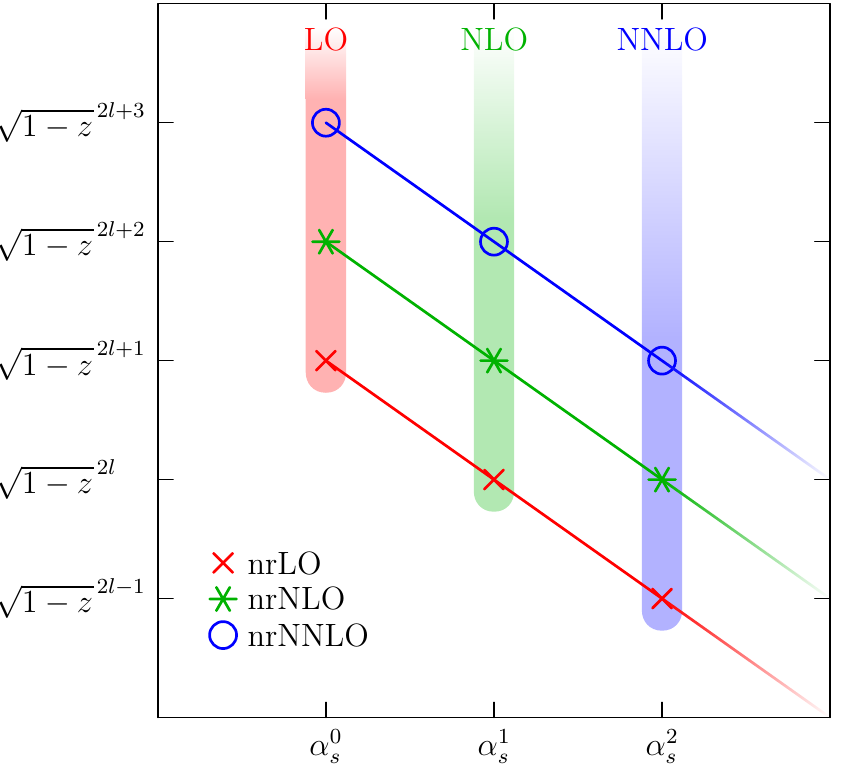
Figure 7 . Relation between relativistic (LO, NLO, NNLO) and non-relativistic (nrLO, nrNLO, nrNNLO) power counting up to next-to-next-to-leading order. The axes show the powers of (cid:11) s p and 1 (cid:0) z in the various coe(cid:14)cients represented by the markers. Note that the normalization is chosen such that (cid:11) 0 corresponds to s